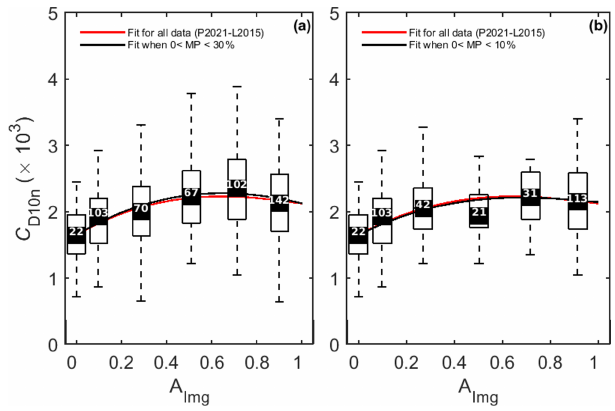
Figure B2. (a) MP < 30% (b) MP < 10%. In each panel, the red curve is the fitting curve obtained for the joint ACSE and AO2016 data, the same as shown in Fig. 8 (P2021–L2015), and the black lines are the fitting curve obtained for the data shown in the “re- spective”